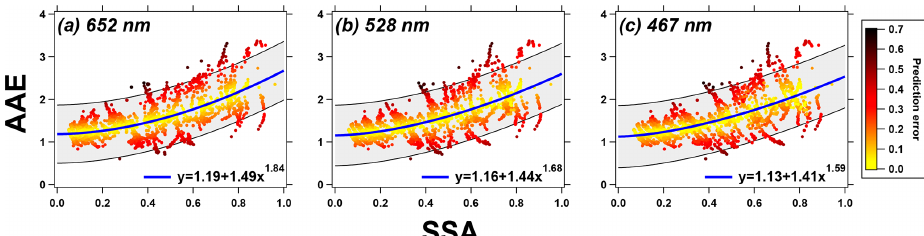
Figure 6. AAE plotted against SSA for the FIREX data. In the figures, AAE was computed using a power-law fit across all three wavelengths, and SSA was computed using the interpolated B scat from the two PAXs and the reported B ATN from the CLAP. The data points are colored by their prediction error (true AAE minus calculated AAE divided by calculated AAE).